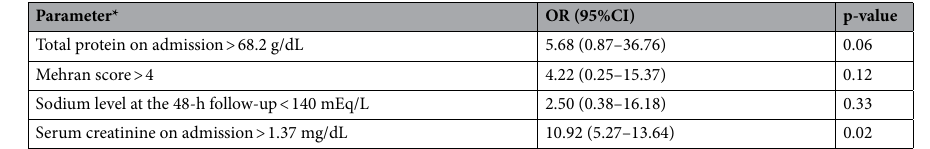
Table 5. Logistic regression analysis of predictors of early subclinical kidney injury. Early subclinical kidney injury was defined as an increase in NGAL by at least 25% 48 h following contrast administration vs. baseline. *Cutoff values for the evaluated parameters were established using receiver operating characteristic